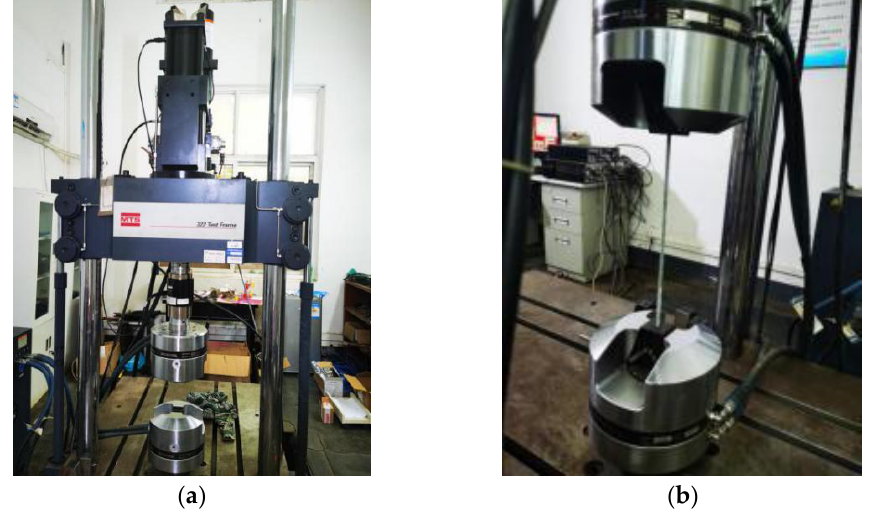
Figure 13. Testing site. ( a ) Tensile tester, ( b ) Fixed-wire conditions.